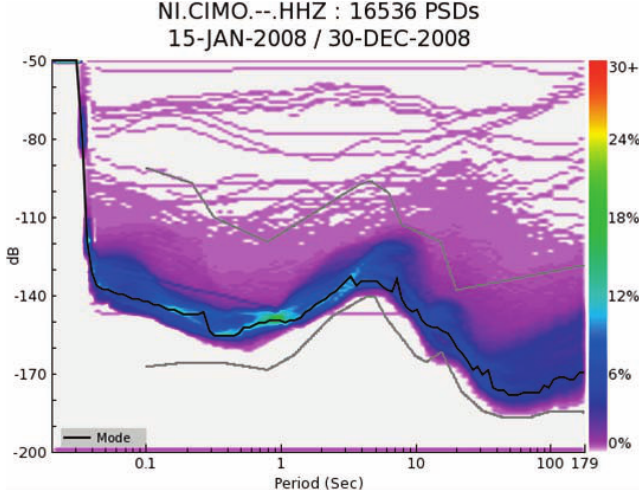
Figure 5. Example of a probability density function of the daily PSDs computed for the HHZ channel of one station of the North-East Italy Seismic Network (CIMO) using one year data (January 15 - December 30, 2008). The gray lines represent the new standard high/low noise model [Peterson 1993], while the black line plots the highest probability power